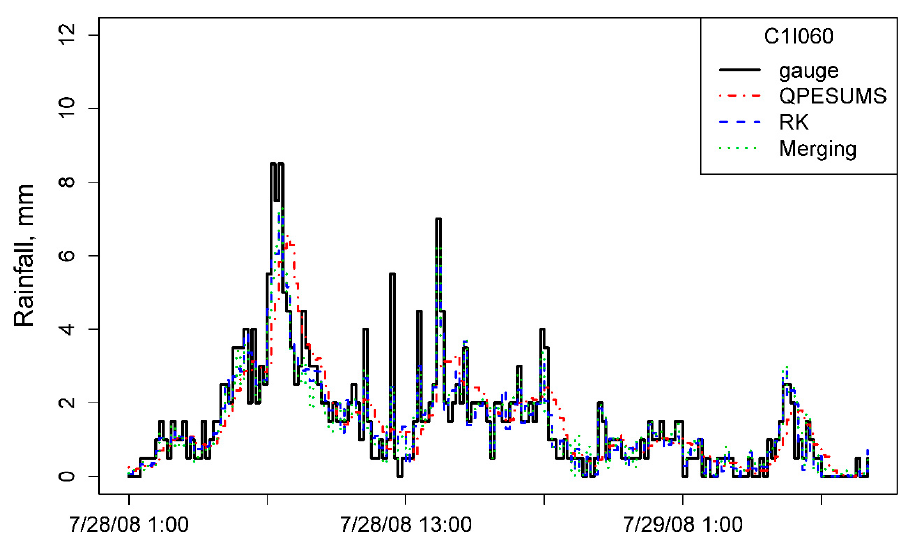
Figure 10. Hyetographs at station C1I060 showing the complete time variations in the rainfall data from RK (adjusted), merging (adjusted), QPESUMS (unadjusted), and gauges for the event of Typhoon Fungwong.